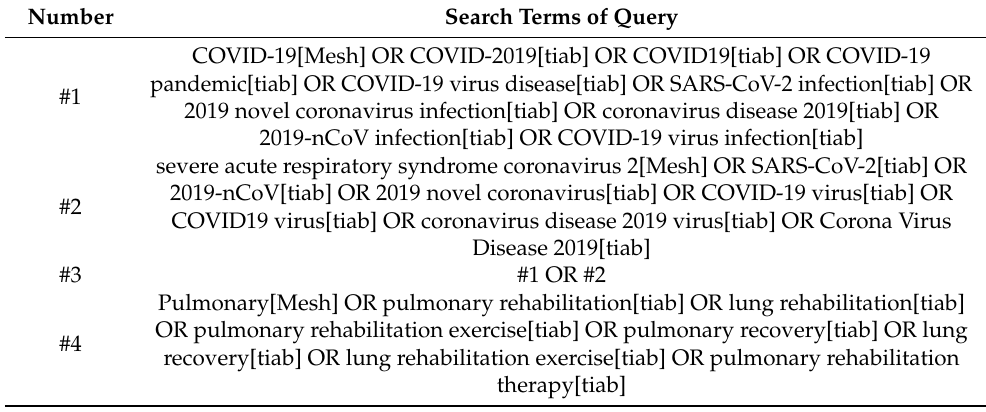
Table 2. Search Strategy for